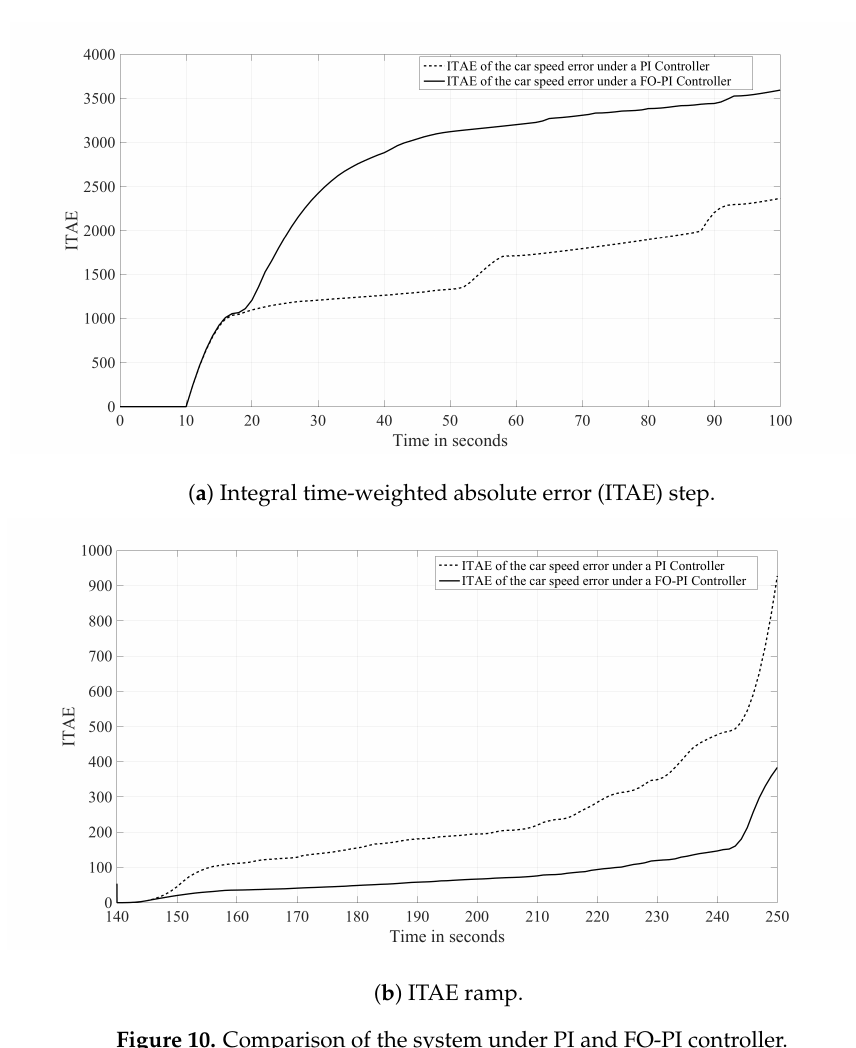
Figure 10. Comparison of the system under PI and FO-PI controller. Table 4. Parameters of the electrical vehicle and the traction